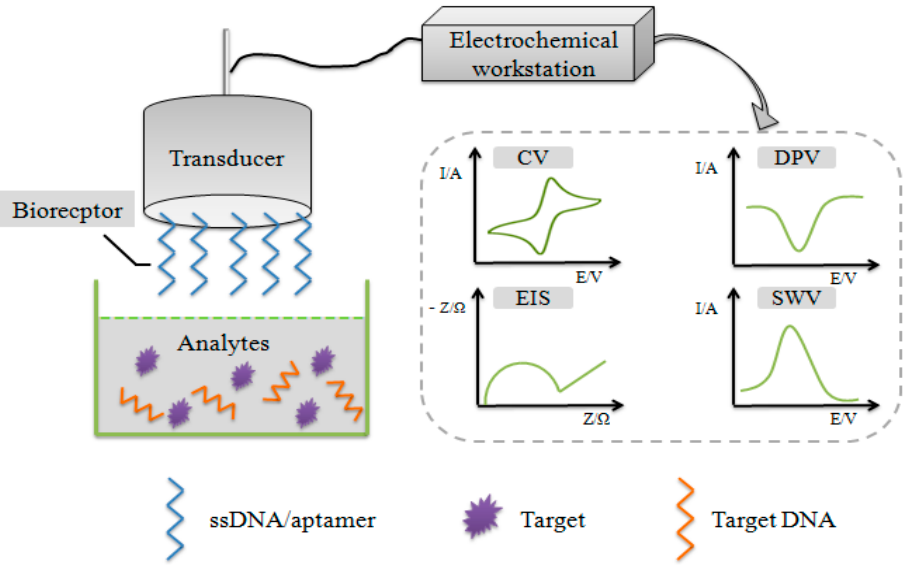
Figure 3. Schematic diagram of electrochemical DNA biosensors.